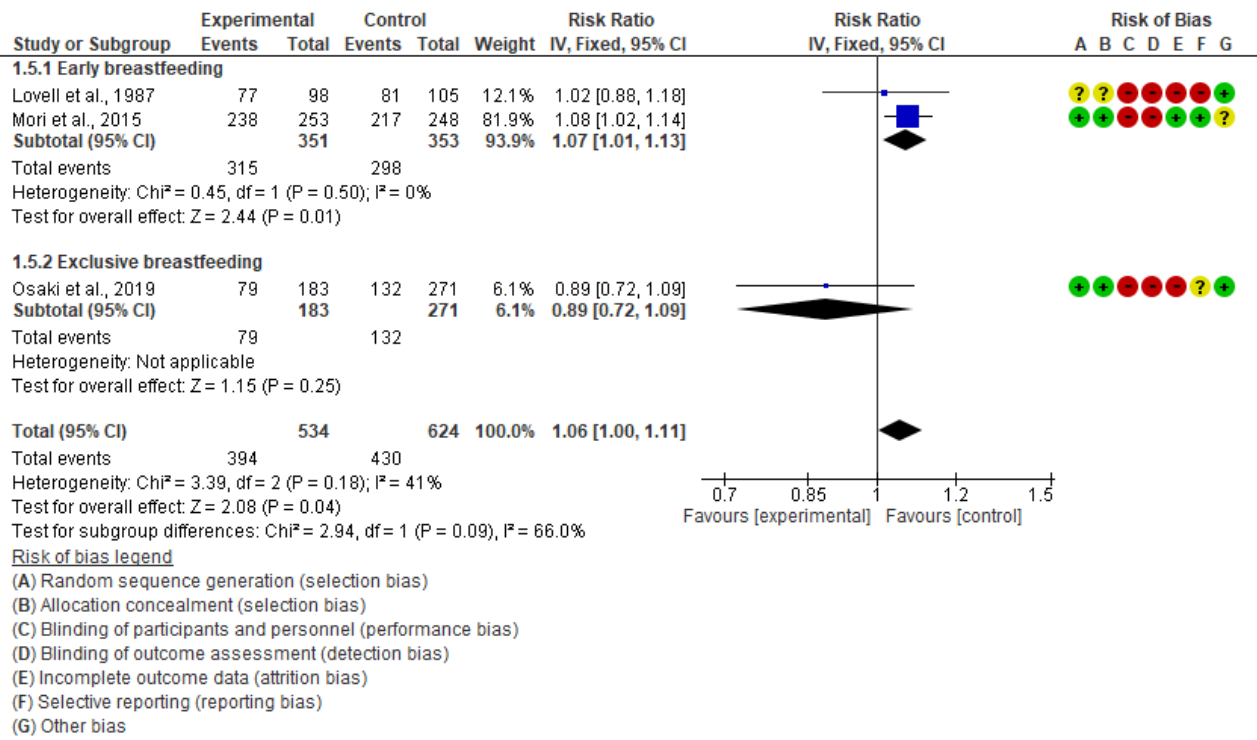
Figure 7. Meta-analysis for the effect of MCH handbook interventions vs. standard care on breast- feeding practice [19,20,22] .